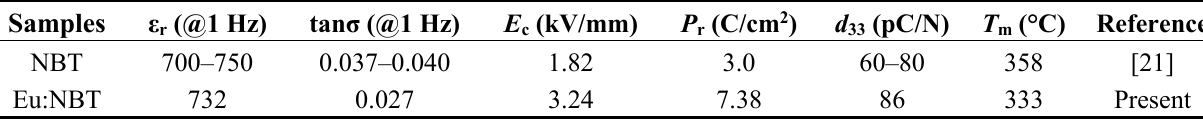
Table 4. Electrical properties of NBT and Eu:NBT single crystals. Reprinted with permission from [30]. Copyright 2014